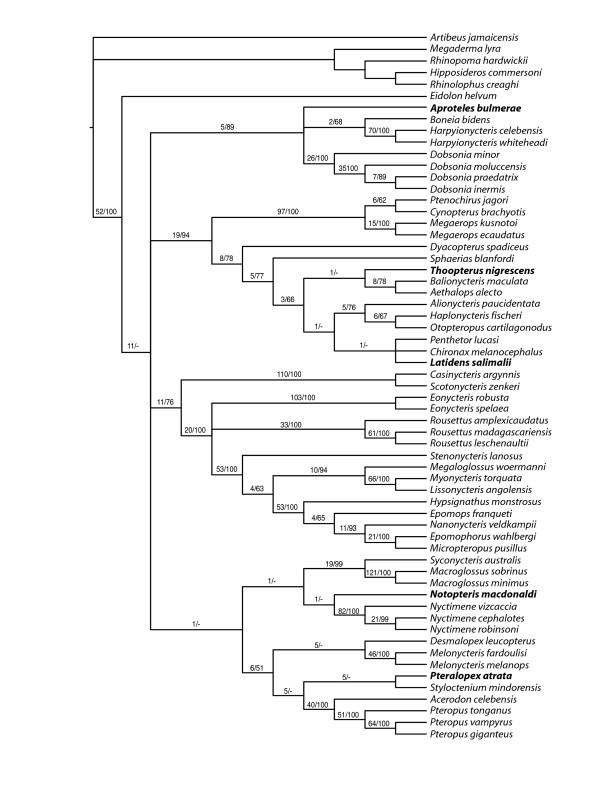
Consensus of six most parsimonious trees obtained with dataset 2. Numbers shown above branches refer to Bremer decay values (left) and bootstrap percentages (right).